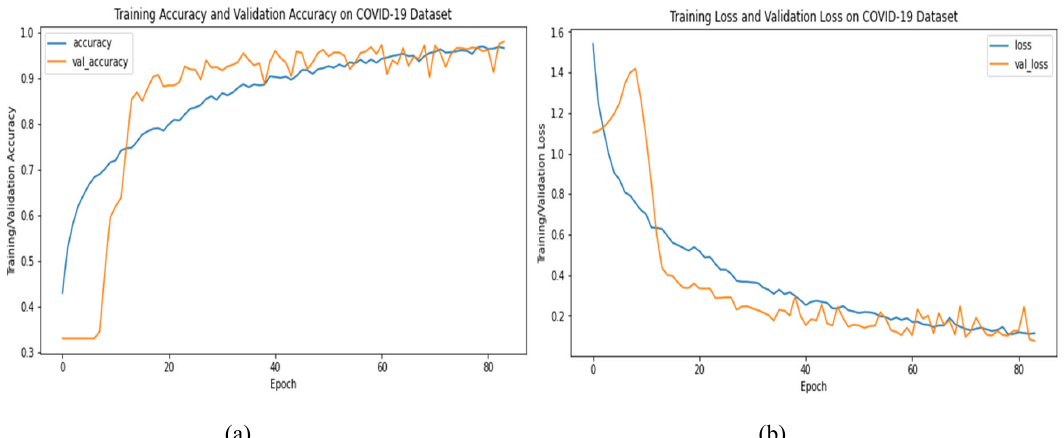
Fig 7. The (a) training and (b) validation on the COVID-19 dataset based on the proposed CNN-LSTM